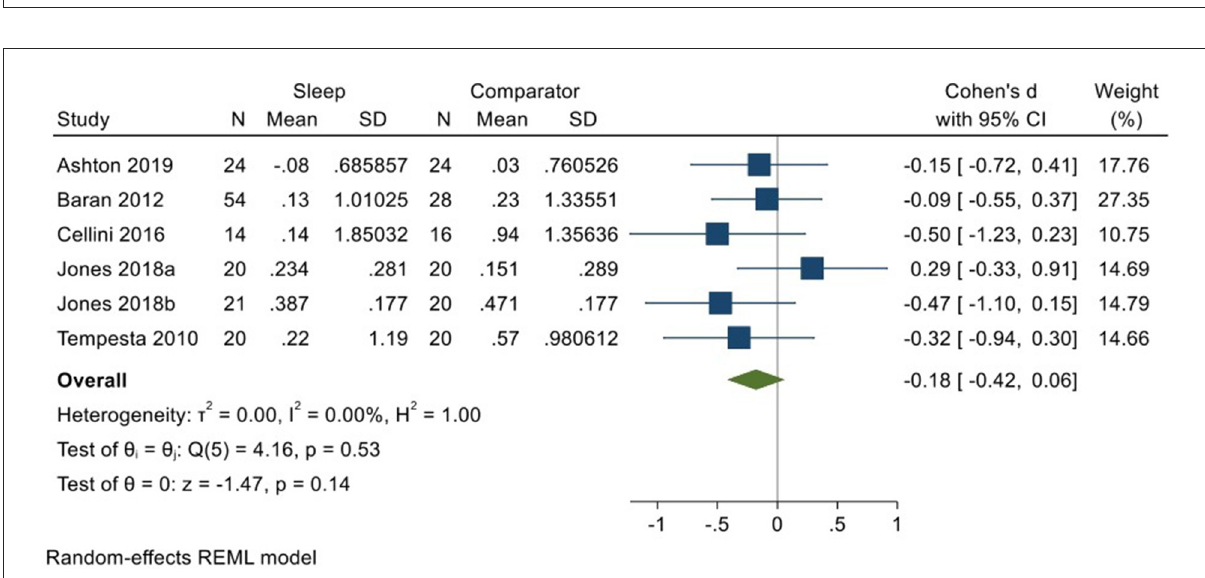
FIGURE10 Meta-analysis VIII: Outcomes for self-reported arousal ratings in response to neutral stimuli – changes across a period of sleep compared to across a period of waking ( K = 6, N = 281).